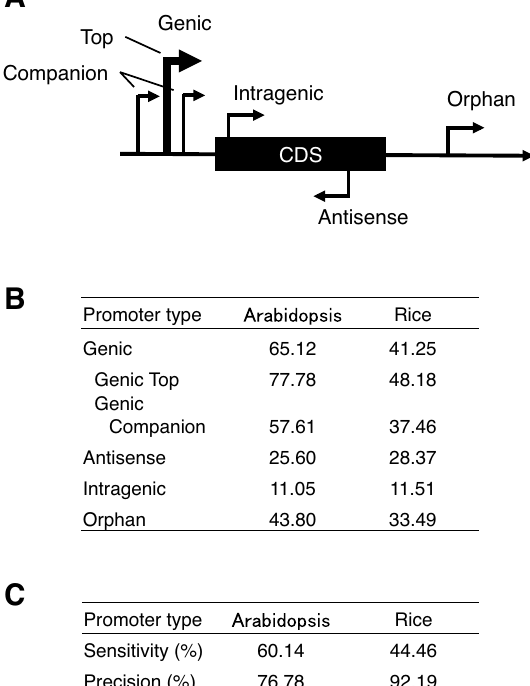
Figure 7. Prediction scores for various promoter types. ( A ) Illustration of promoter types. Experimentally identified TSS clusters (= promoters) are classified as shown (Tokizawa et al., 2017). There are three genic promoters for a gene on average. The strongest one is called the Genic Top, and the others Genic Companions. Orphans are the promoters whose corresponding gene model does not exist. ( B ) Sensitivity of prediction according to promoter types. Genome-wide prediction is done. ( C ) Results of promoter prediction considering promoter direction for Genic Top promoters. In this prediction, results are negative if the prediction of the direction is wrong, even if positional prediction is correct. Directional prediction was achieved by comparison of the peak height for the forward and reverse